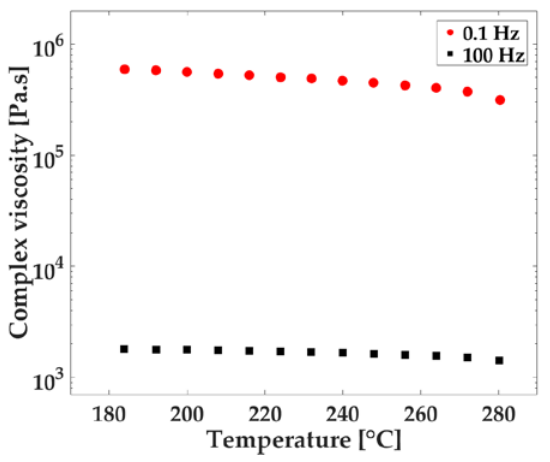
Figure 5. Complex viscosity versus temperature.